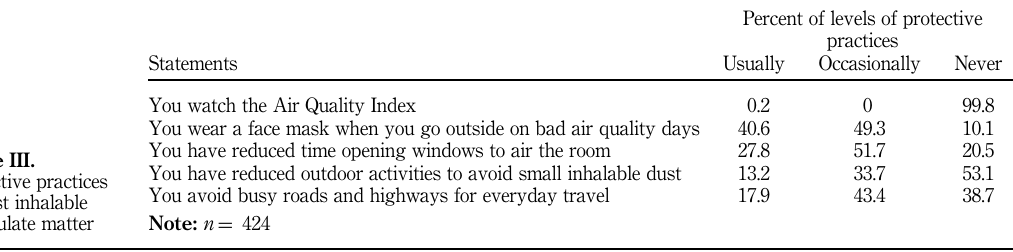
against inhalable particulate